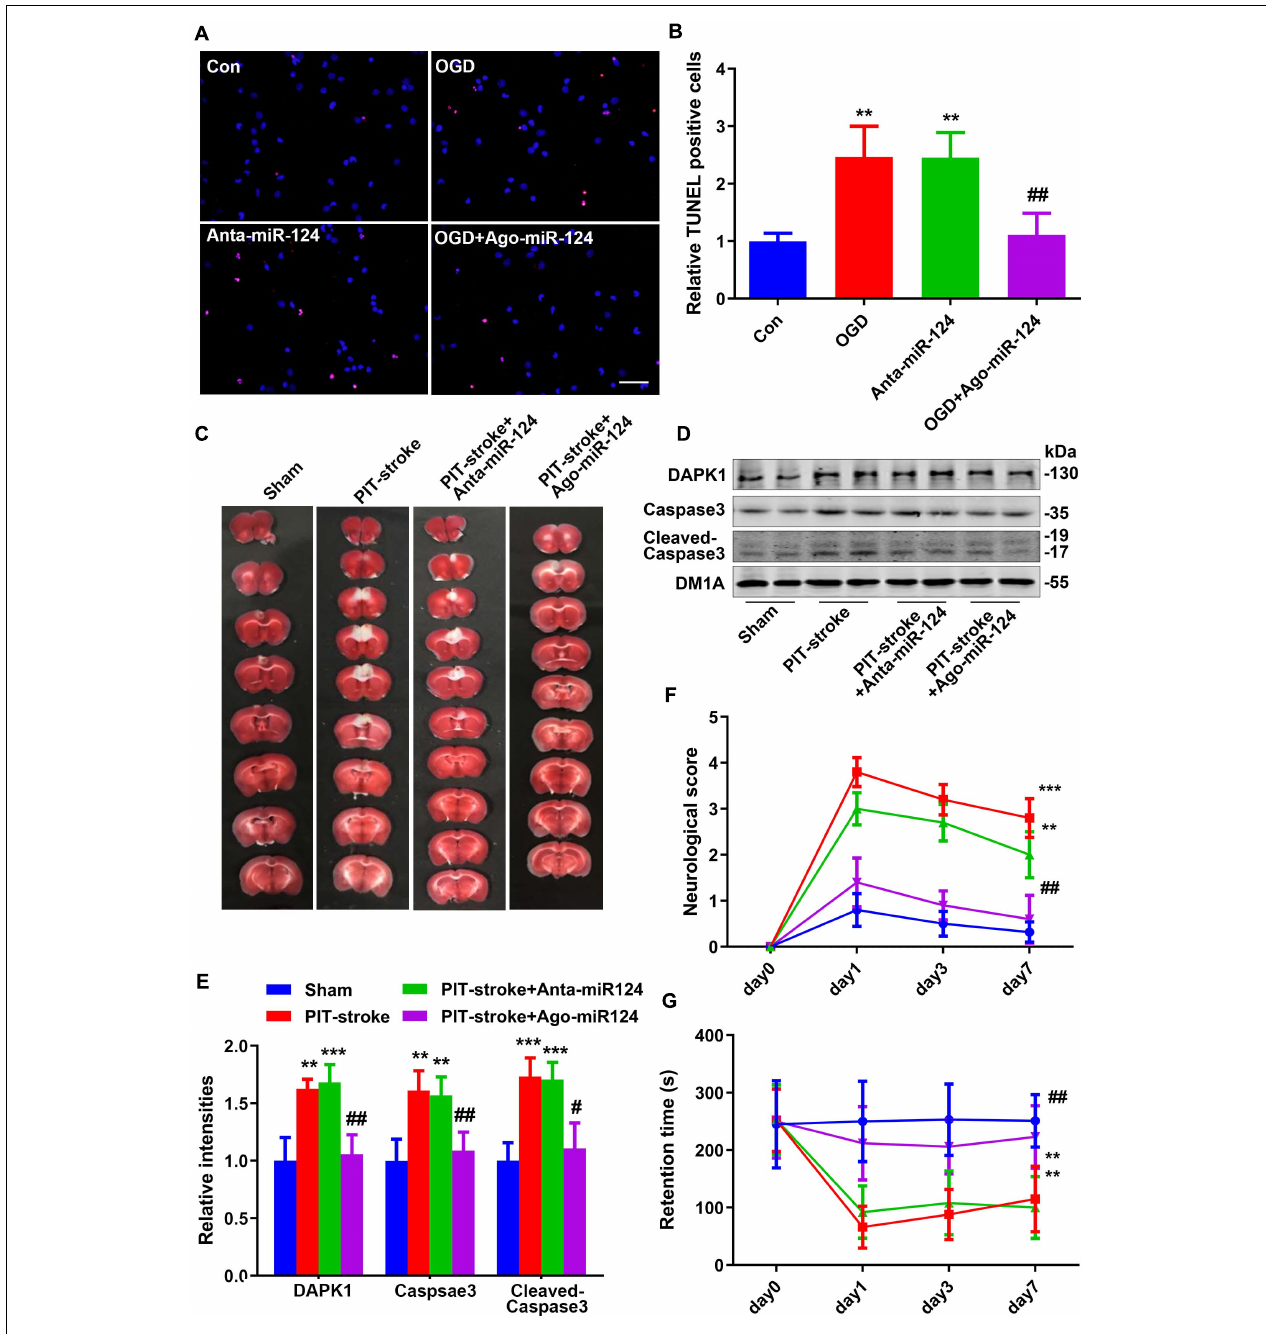
FIGURE 4 | miR-124 protected against PIT-stroke damage. (A) TUNEL staining was performed in primary cultured neurons after OGD treatment with different miR-124 levels (scale bar = 50 µ m) and quantified (B) . Data are presented as mean ± SD ( n = 4/group). ** p < 0.01 vs. Con, ## p < 0.01 vs. OGD group. (C) Representative images of TTC staining depicting Ago-miR-124-induced protection against PIT-stroke damage. Levels of DAPK1, caspase-3, and cleaved caspase-3 were measured by western blotting (D) and quantitatively analyzed (E) . Neurological scores (F) and performance on the rotarod test (G) were tested on day 1, day 3, and day 7 after PIT-stroke among different groups. Data are presented as mean ± SD ( n = 6/group). ** p < 0.01, *** p < 0.001 vs. Con, # p < 0.05, ## p < 0.01 vs. OGD